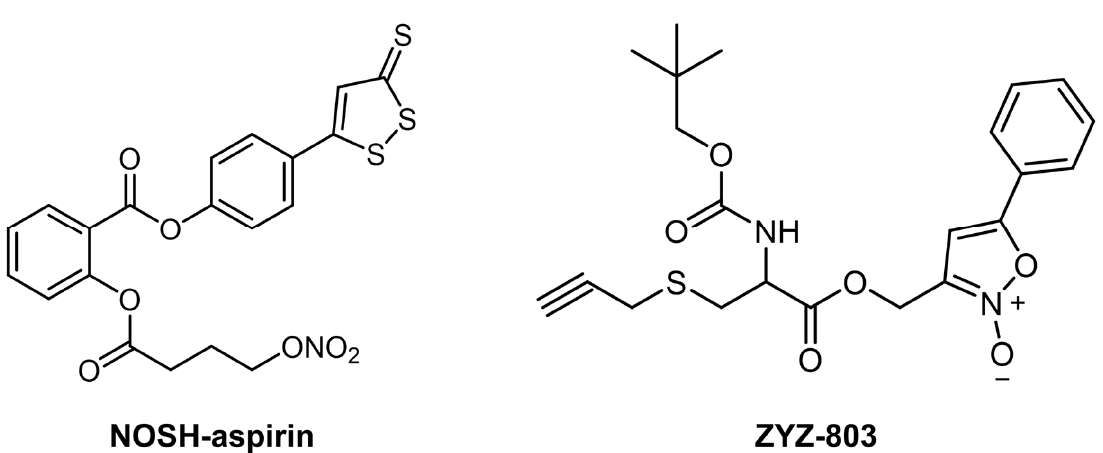
Figure 9. The chemical structures of NOSH-aspirin and ZYZ-803.